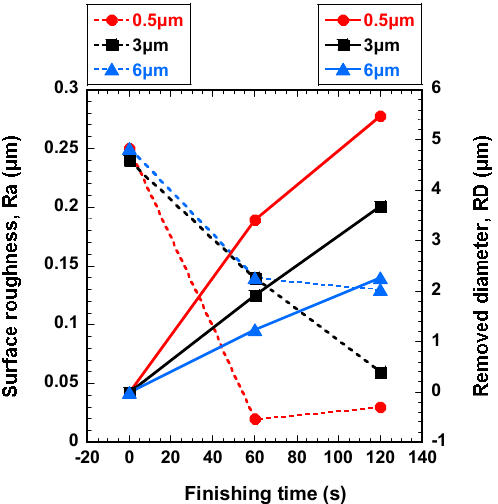
Figure 6. Effect of unbonded magnetic abrasive grain size on surface roughness and the removed diameter (rotational speed: 800 rpm, 10 Hz).